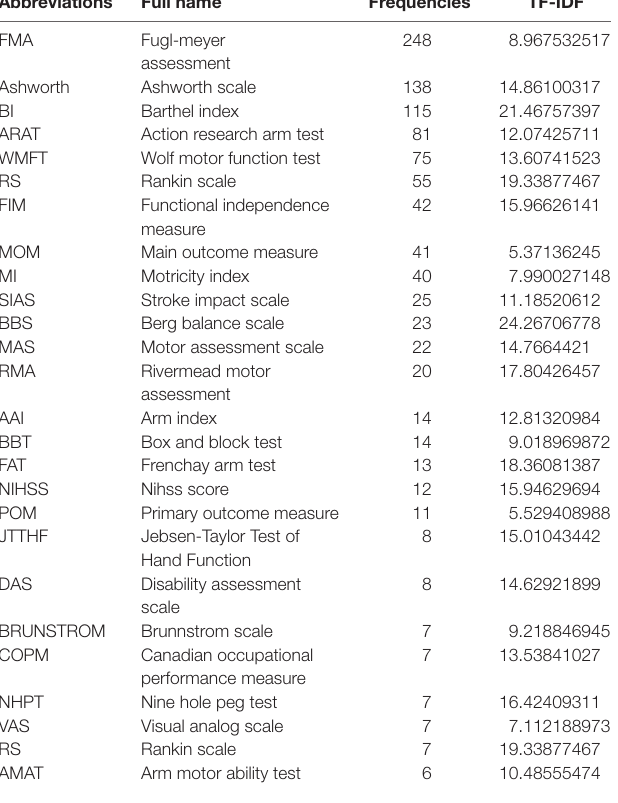
TABLE 1 | Stroke_Scales dataset items with frequencies and term frequency-inverse document frequency (TF-IDF).